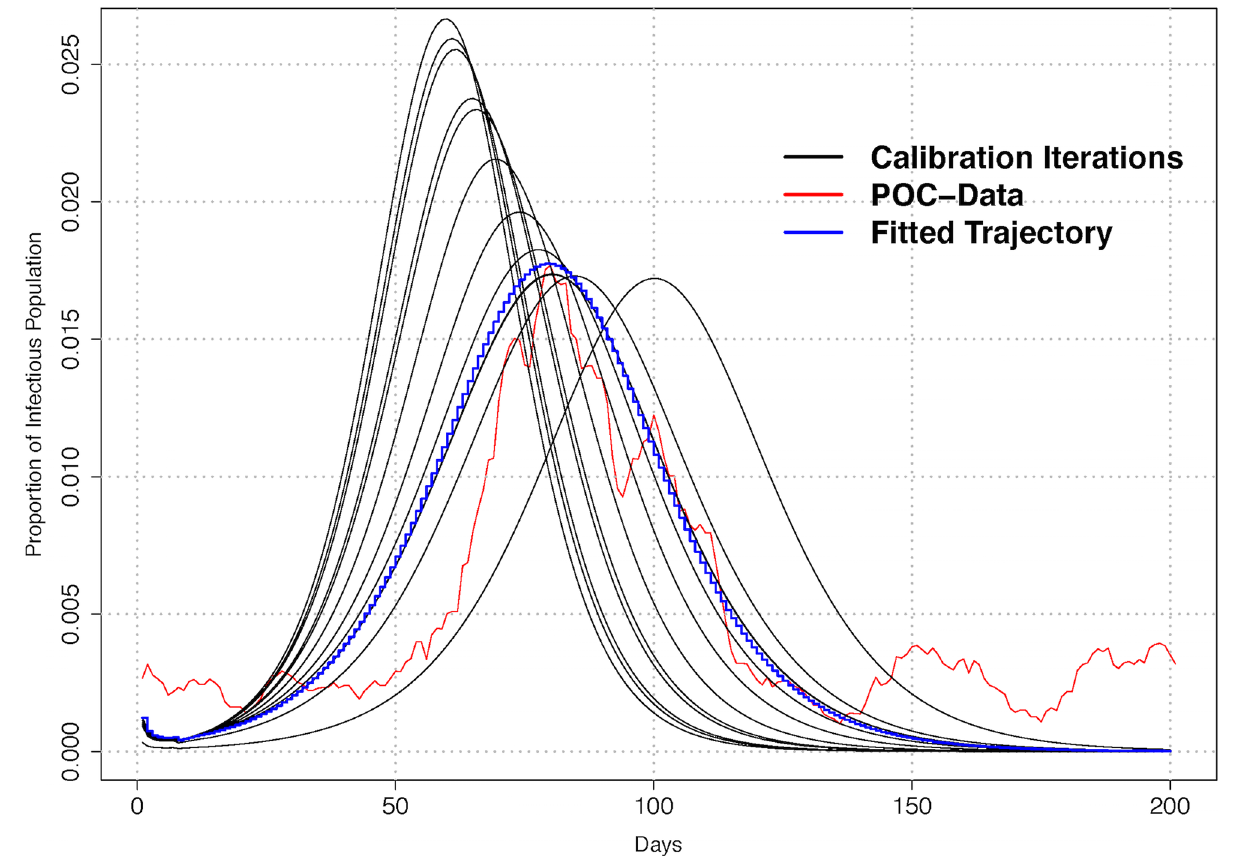
Fig 1. Sample convergence of simulation iterations to POC-Data.